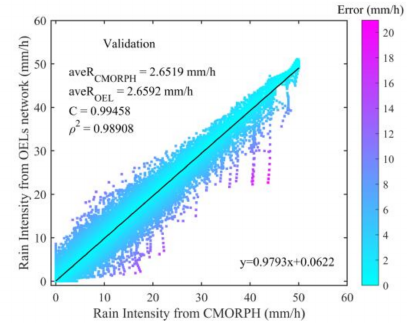
Figure 10. The comparisons between inversed rain intensity of all grid cells derived from OELs network and original values from CMORPH during plum rain season (June, July) of 2016, 2017, 2018 and 2019.